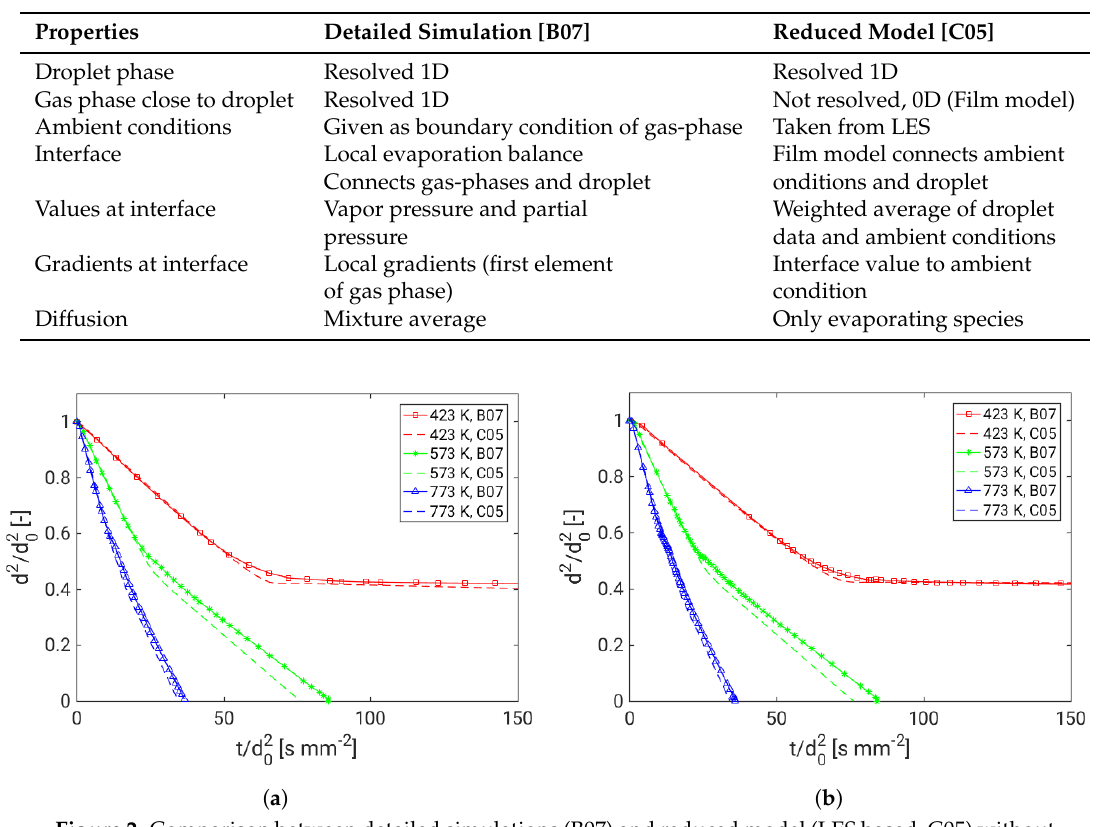
Table 2. Comparisons properties between detailed simulations and the LES-based Eulerian–Lagrangian.